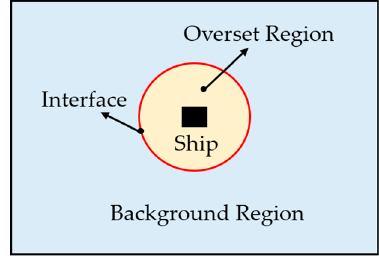
Figure 1. Sketch of the simulation domain.